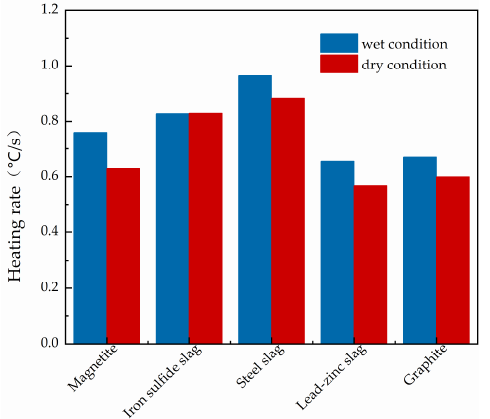
Figure 16. Heating rate of the surface of concrete slabs under dry and wet conditions for specimens of microwave-absorbing cement concrete made from different materials (°C/s).